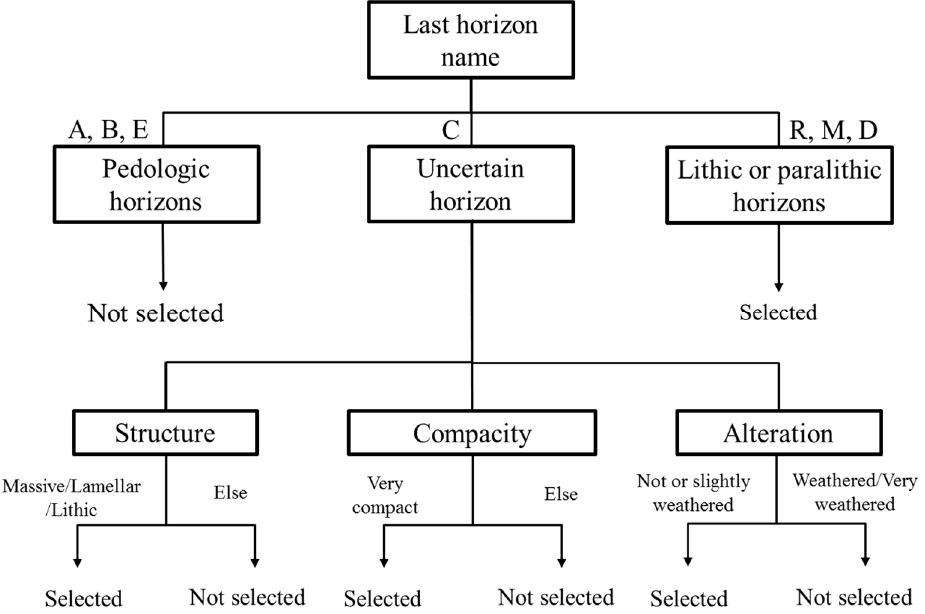
Figure 4. Representation of the classification tree applied to the dataset for identifying lithic or paralithic horizons and for selecting the input sites.